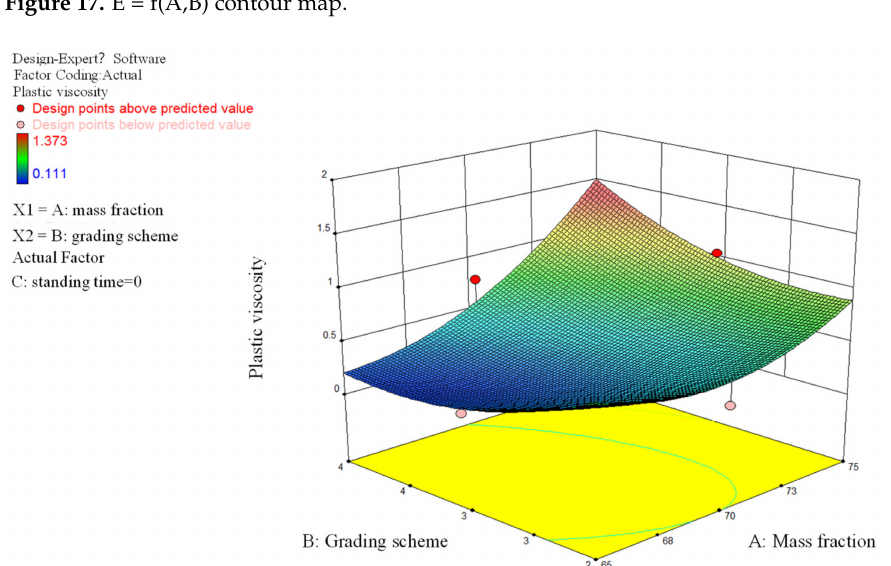
Figure 18. E = f(A,B) response surface